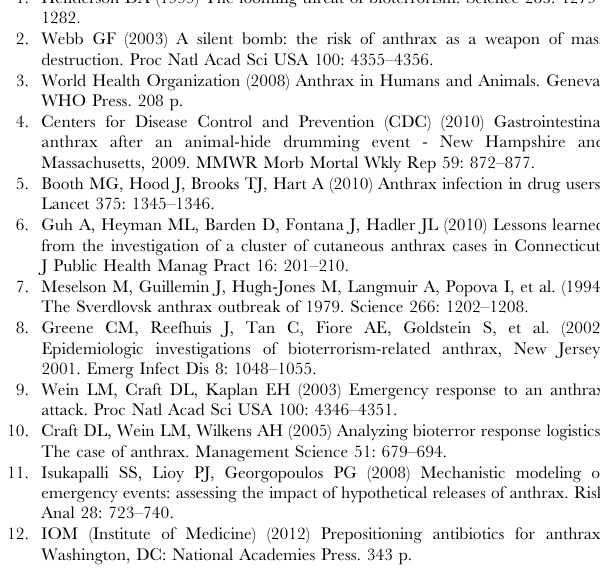
Table S2 Data from Brachman et al. [ 24 ] Run 3: 32 monkeys. We recorded dose data from text in [24] where available. Otherwise, we visually estimated the daily doses from Figure 3 therein. a Two sacrificed animals found to be infected with anthrax on day 50. b We consider data from days of sacrifice to be number of animals infected by that day. Table S3 Data from Brachman et al. [ 24 ] Run 4: 31 monkeys. We recorded dose data from text in [24] where available. Otherwise, we visually estimated the daily doses from Figure 3 therein. a We consider data from day of sacrifice to be number of animals infected by that day. Table S4 Data from Brachman et al. [ 24 ] Run 5: 28 monkeys. We recorded dose data from text in [24] where available. Otherwise, we visually estimated the daily doses from